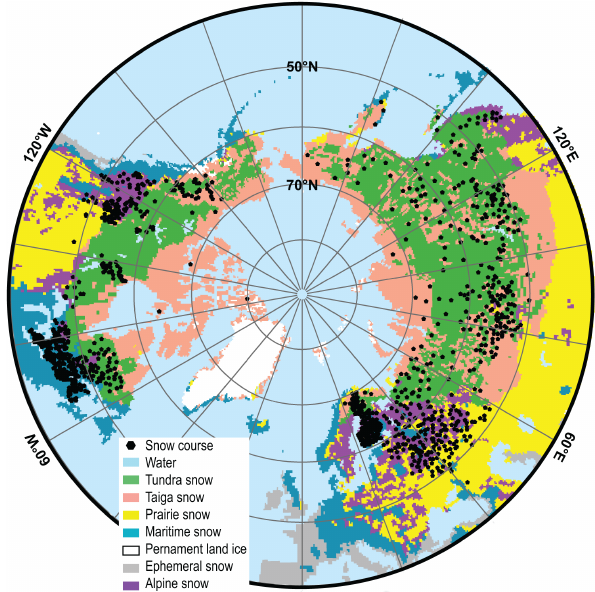
Figure 2. Centroid of 25km EASE grid cells with snow course ob- servations used in the analysis (Sect. 2.3) overlaid on snow-climate classes (Sturm et al.,